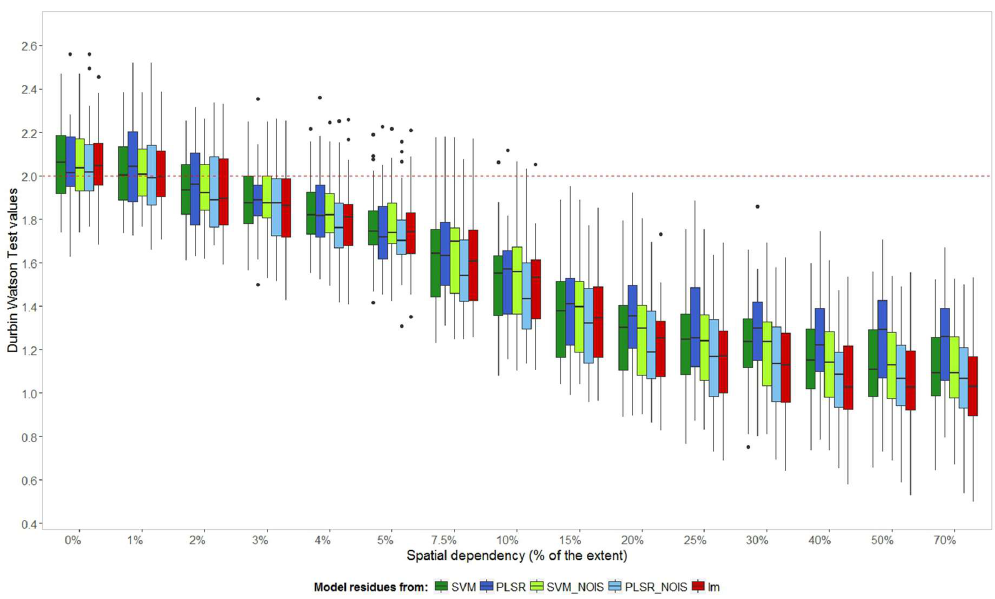
Figure 7. Durbin Watson test for model residues of the training model per regression technique and tuning approach.